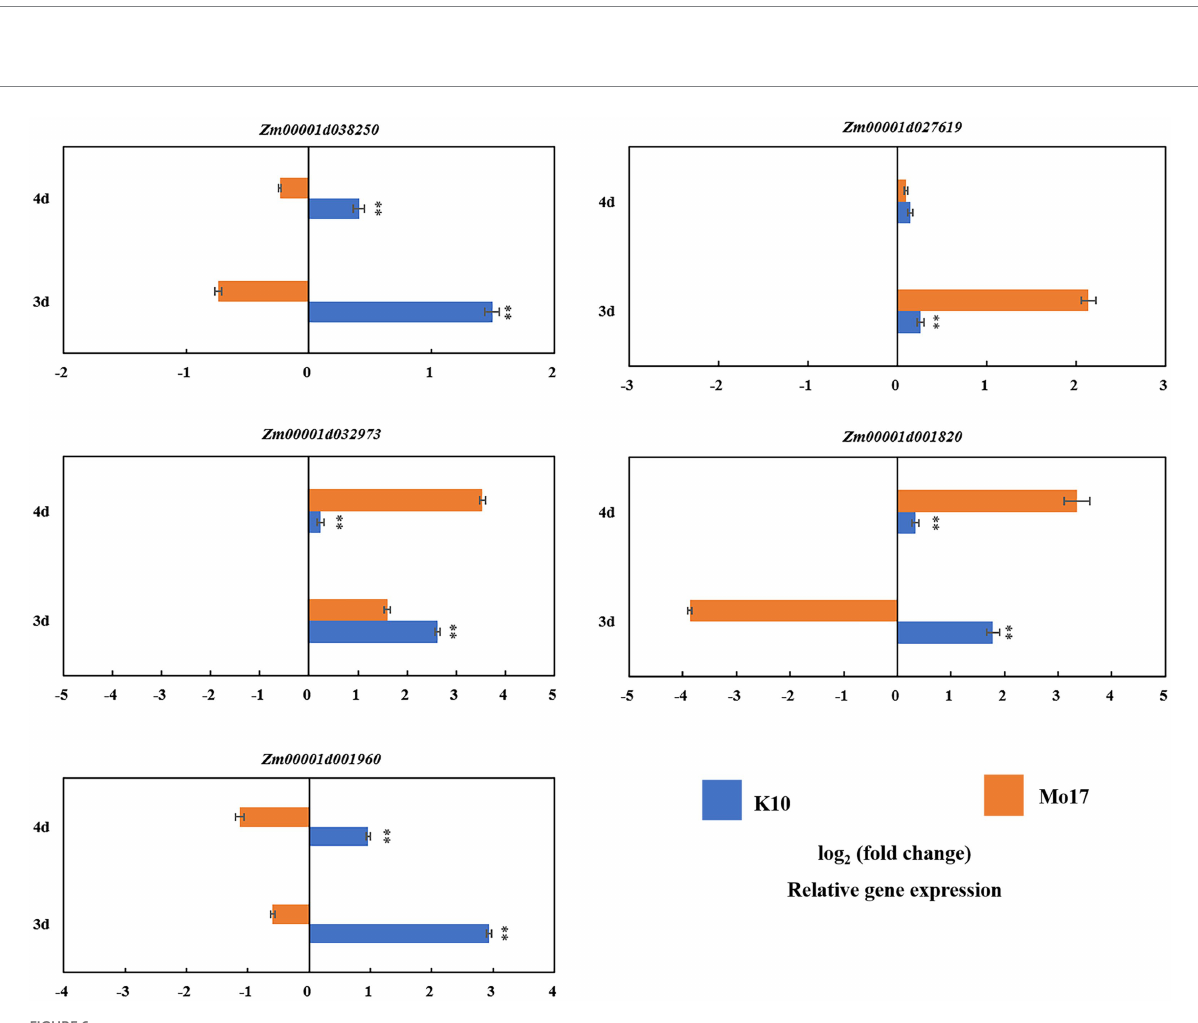
FIGURE 6 qRT-PCR validation of the GWAS and RNA-seq results. Expression of five candidate genes in alkaline-tolerant inbred line K10 and the alkaline- sensitive inbred line Mo17. Expression analysis was conducted on leaf that were collected at 3 and 4 days under normal control treatment and alkaline treatment, respectively. ** indicate significance at p <